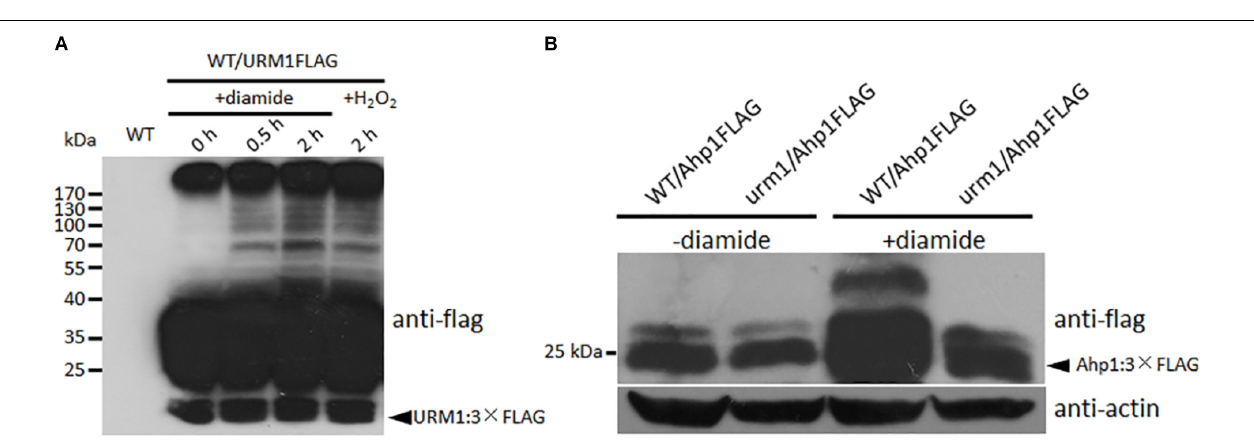
FIGURE 9 | URM1 is responsible for modification of Ahp1. (A) Total urmylation level is responsive to oxidative stress. Total lysates of the WT/URM1FLAG strain under different conditions were subjected to SDS-PAGE and immunoblotted using anti-flag antibodies to detect total urmylation levels. (B) Ahp1 is modified by URM1. Ahp1:3 × Flag fusion constructs were transformed into the wild type and the (cid:49) urm1 mutant, respectively. Corresponding transformants cultured with or without 1.5 mM diamide were analyzed by western blotting with anti-flag antibody. Triangle indicates the Ahp1:3 × Flag fusion protein bands. The β -actin levels detected by anti-actin were used as a loading